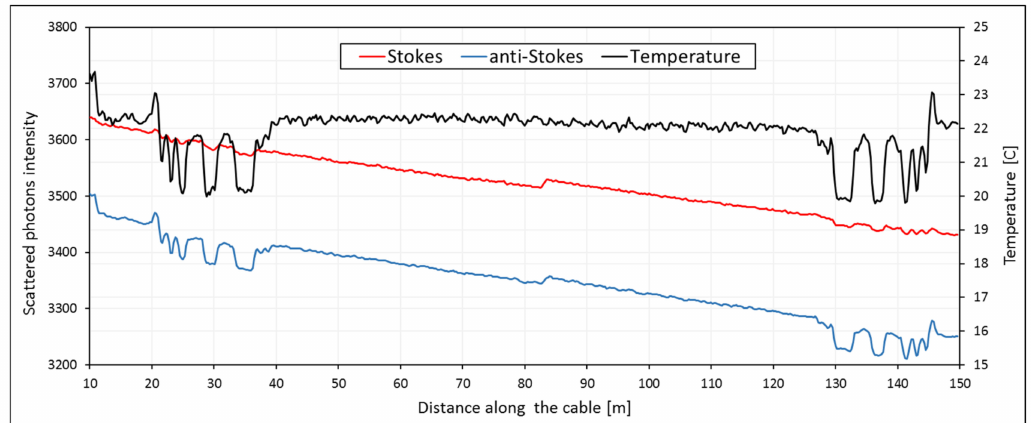
Figure 1. Stokes and anti-Stokes intensity and obtained temperature from the laboratory DTS measurement using the Silixa XT-DTS